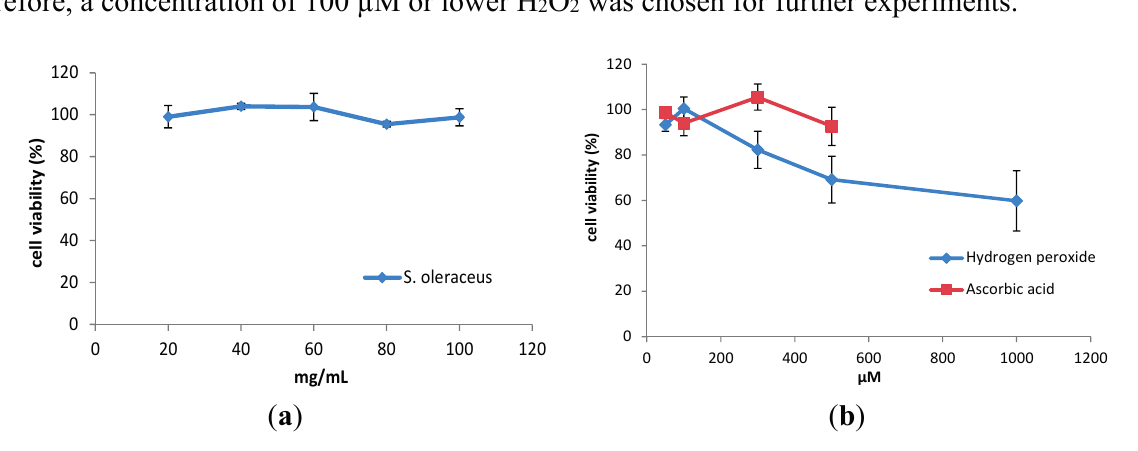
Figure 1. Viability of WI-38 cells after treatment with ( a ) various concentrations of S. oleraceus leaf extracts from 20 to 100 mg/mL and ( b ) 50–1000 μ M H 2 O 2 or 50–500 μ